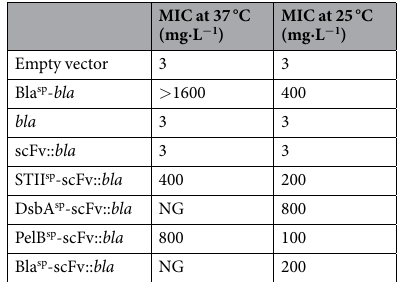
Supplemental Fig. S3) was ligated with each signal peptide pool, electroporated into E . coli ElectroSHOX, recov- ered in LB medium without selection for one hour, then transferred to a flask and grown for 12–18 hours with